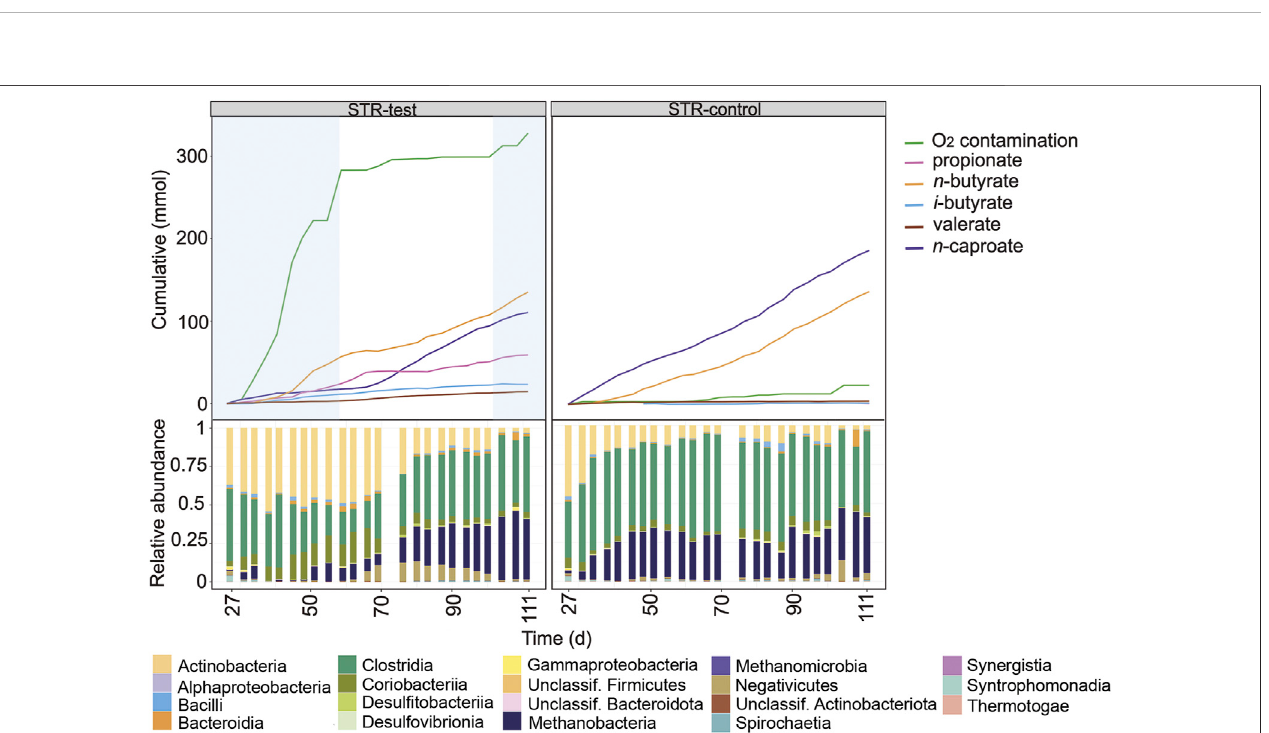
FIGURE2| Pro fi lesofthecumulatedamountsofcarboxylatesandO 2 ,aswellascommunitycompositionatclasslevelbetweendays27and111forSTR-testand STR-control. Blue shading indicates the O 2 contamination period.